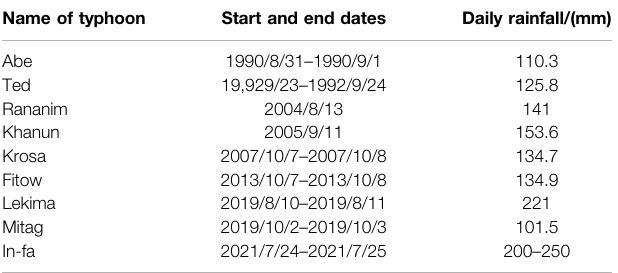
TABLE 2 | Statistical table of typhoons affecting rainfall in Xinchang county from 1990 to 2021.